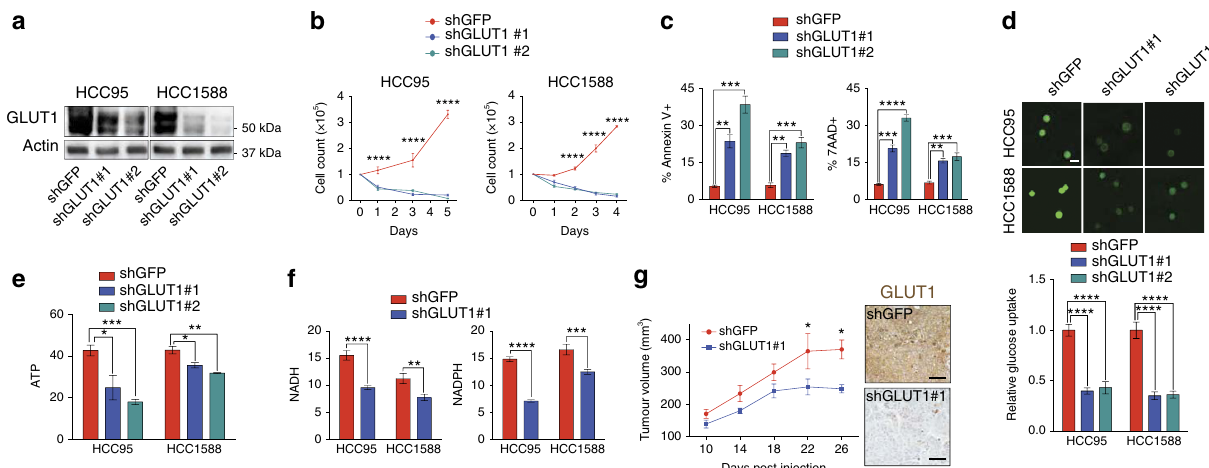
Figure 3 | GLUT1 knockdown inhibits lung SqCC tumour growth. ( a ) Immunoblot analysis of GLUT1 expression in control shGFP and shGLUT1 HCC95 and HCC1588 cells. ( b ) In vitro proliferation of control shGFP and shGLUT1 HCC95 and HCC1588 cells ( n ¼ 6 from two biologically independent experiments for each construct). Two-way ANOVA, **** P o 0.0001. ( c ) Cell viability was assayed via Annexin-Vand 7-AAD staining in control shGFP and shGLUT1 HCC95 and HCC1588 cells ( n ¼ 3 from three biologically independent experiments for each construct). ANOVA, **** P o 0.0001, *** P o 0.001, ** P o 0.01. ( d ) Representative fluorescent images (top), and quantification (bottom) of fluorescent glucose uptake in shGFP and shGLUT1 HCC95 and HCC1588 cells ( n ¼ 3, six to nine images were captured in each group for quantification). One-way ANOVA, **** P o 0.0001. Scale bar, 25 m m. ( e , f ) Comparison of relative intracellular ATP ( e ), NADH and NADPH ( f ) levels between shGFP and shGLUT1 HCC95 and HCC1588 cells ( n ¼ 6 each group from two to three biologically independent experiments). Two-tailed t -test, **** P o 0.0001, *** P o 0.001, ** P o 0.01, * P o 0.05. ( g ) In vivo tumour growth (left) and representative GLUT1 IHC images (right) of shGFP and shGLUT1 HCC95 xenograft tumours ( n ¼ 3–5 for each group). Scale bar, 100 m m. Two-way ANOVA, * P o 0.05. All error bars represent the mean ± (Fig. 4d). OCR is also elevated in SqCC cell lines when cultured in 25 mM glucose. Likewise, near physiological glucose (5 mM) resulted in a significant reduction of OCR only in SqCC cell lines (Fig. 4e). We speculated that this reduction in lactate production and OCR was associated with a disruption of cellular bioener- getics. Indeed, SqCC cell lines grown in media containing 5 mM glucose exhibit significantly reduced intracellular ATP, NADH and NADPH levels compared to cells grown in 25 mM glucose (Fig. 4f–h). However, ADC cell lines exhibited no change in ATP, NADH or NADPH levels between cells grown in 5 mM glucose or 25 mM glucose. It is possible that the change in SqCC bioenergetics represents a higher capacity for glucose uptake and utilization, whereas in 25 mM glucose, glucose uptake in ADC becomes saturated. To validate whether this fluctuation in bioenergetics represents a substantial reliance on glucose, but not an artefact of non-physiologically elevated glucose uptake due to high GLUT1 level in SqCC cell lines, we cultured SqCC and ADC cell lines in decreasing concentrations of glucose. At 5 mM glucose concentration, reduced intracellular ATP, NADH and NADPH (Fig. 4f–h) is associated with a significant decrease in cellular viability compared to ADC cell lines (Fig. 4i), indicating that SqCC cell lines are significantly more sensitive to glucose concentrations than ADC cell lines. Lower than physiological glucose concentrations further decreased the cellular viability of SqCC cell lines. Furthermore, metabolic flux analyses in ADC and SqCC cell lines cultured in 5 mM glucose after glucose starvation revealed that cellular glycolytic flux (extracellular acidification rate, ECAR) is significantly more elevated in SqCC cell lines compared to ADC cell lines (Fig. 4j). OCR was markedly decreased in SqCC compared with a divergent increase in ADC (Fig. 4j). In accordance with SqCC-specific susceptibility to GLUT1 knockdown, these distinct metabolic responses strongly suggest a unique reliance on glucose by SqCC but also provide a rationale for decreased cell viability upon glucose deprivation.